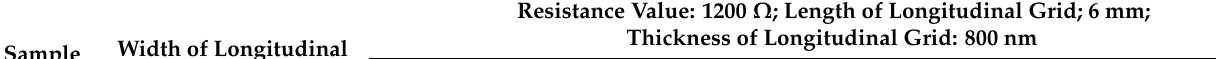
Table 2. Geometric dimensions of thin-film resistor grids with different widths.